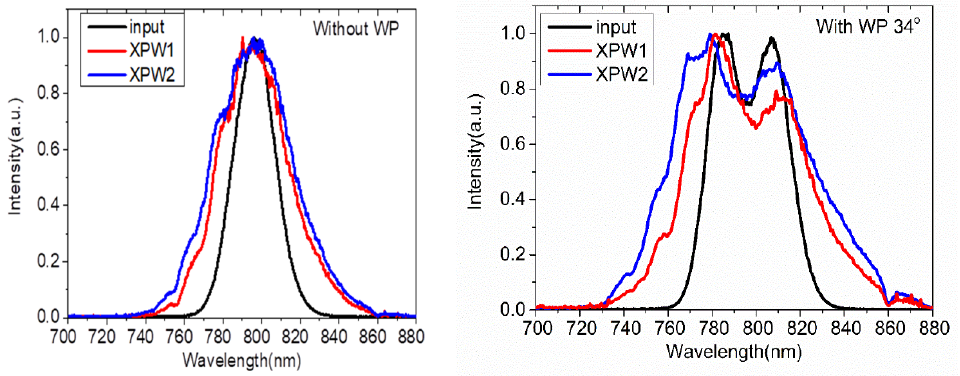
Figure 9. Typical spectra of the input laser beam, XPW with 1st BaF 2 crystal (XPW1) and XPW with 1st and 2nd BaF 2 crystals (XPW2), under the condition of being without the WP and being with the WP at an angle of 34°.